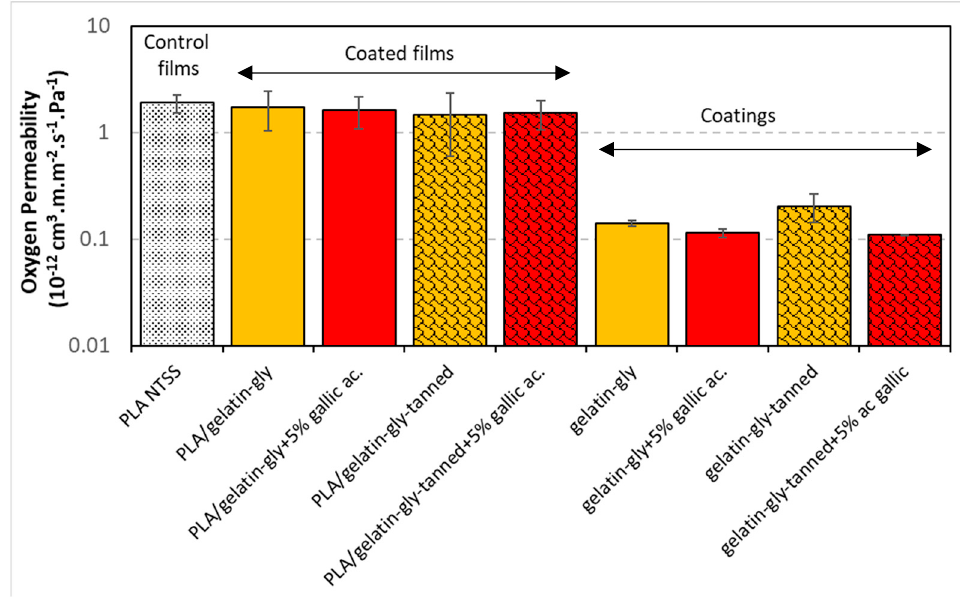
Figure 10. Oxygen barrier properties of coated films and coatings measured at 85% RH (coated side exposed to RH = 85%).